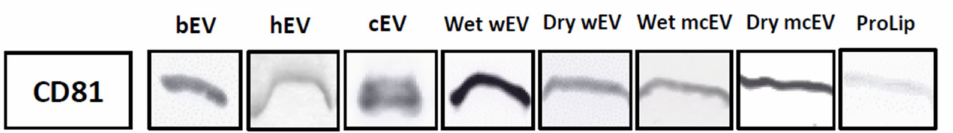
Figure 1. CD81 Western blot of EV isolates. Western blots were conducted on aliquots of pools from the individual EV isolations using a Sephacryl S-500 SEC column (for chromatograms see Supplementary Figures S1 and S2). Six µ g of each EV isolate were separated on an 18% SDS-PAGE, transferred to a PVDF membrane and probed for CD81, a classical EV surface marker. Eight µ g of proteoliposomes (ProLip) were used for the Western